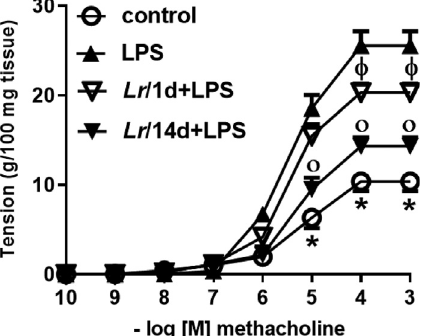
Fig. 10. Bronchial hyperreactivity. The C57Bl/6 mice were treated with Lactica- seibacillus rhamnosus (10 9 CFU of Lr in 300 µ L of PBS, orogastric by gavage) for 14 days or one day, before E. coli LPS instillation (0.5 mg/Kg, intranasal). The mice were euthanized 24 h after the LPS. The bronchial hyperreactivity were processed according to Materials and Methods. Measurement of BSM contraction forces were performed by varying the concentration of MCh-levels from 10 ‒ 10 to 10 ‒ 3M. The results are expressed as mean ± SEM. Statistically signi fi cant dif- ferences p < 0.05 comparing the groups (control, Lr /1d+LPS, Lr/ 14d+LPS) with the LPS group are represented by the symbols in the fi